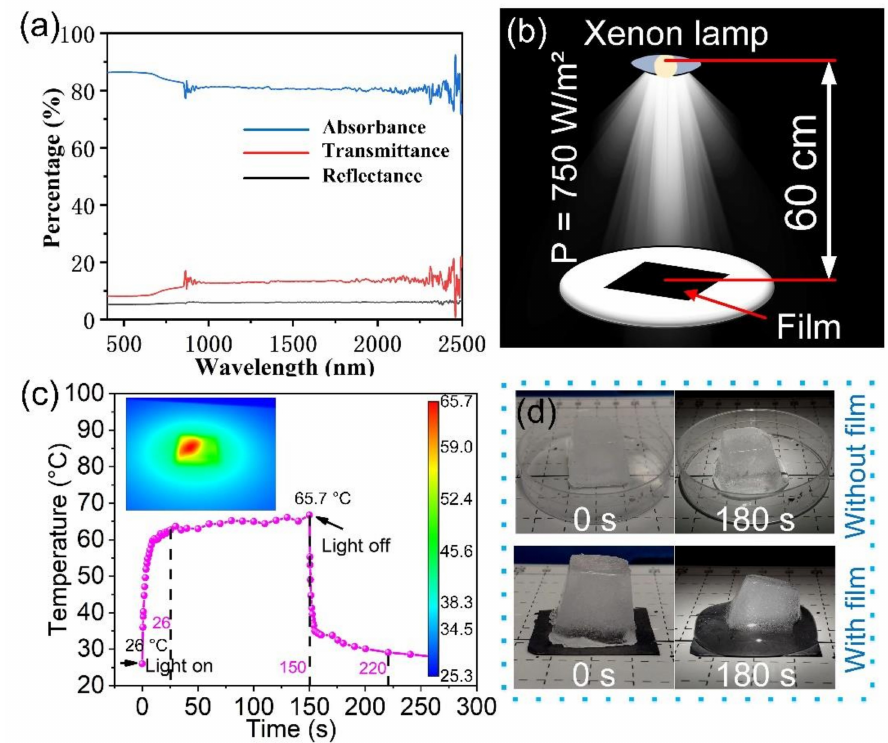
Figure 5. ( a ) Vis-NIR absorbance, reflectance, and transmittance of CFG film. ( b ) Diagram of photo- thermal apparatus for testing photo-thermal response of the CFG film. ( c ) Photo-thermal response of the CFG film (30 × 30 mm 2 ). ( d ) Comparison of fast deicing effect of the CFG film without and with